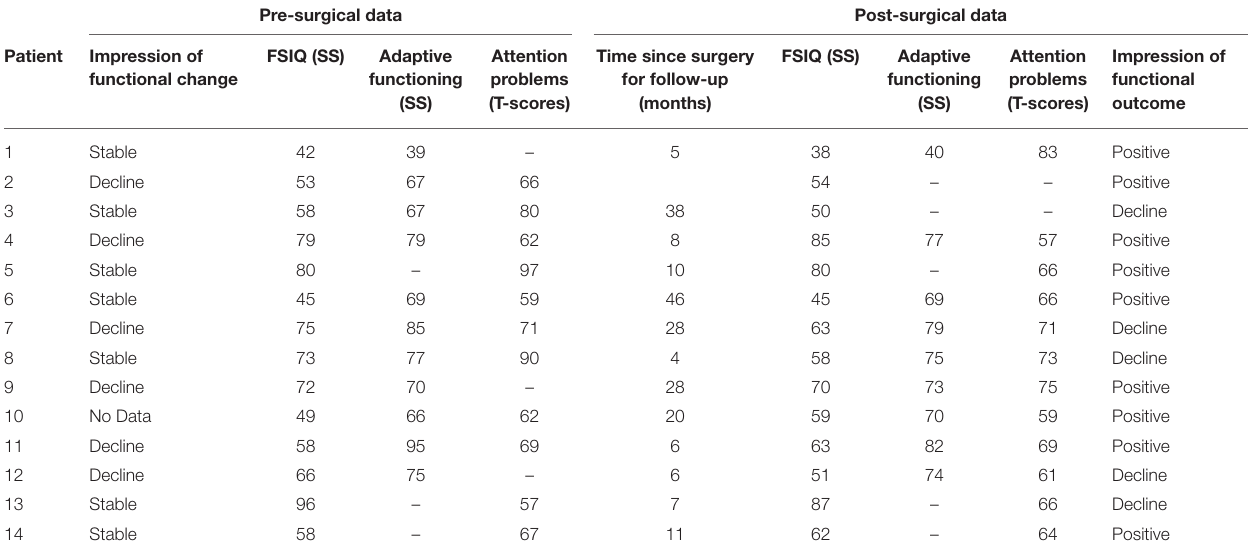
TABLE 4 | Individual pre- and post-surgical intellectual, adaptive and behavioral data.